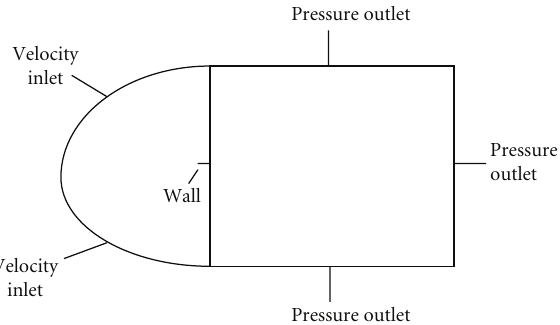
Figure 3: The flow domain with the boundary